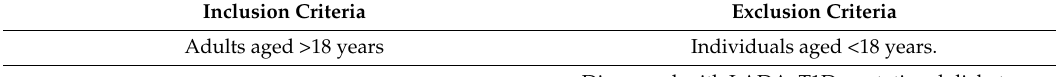
Table 1. Inclusion and exclusion criteria for the 3D Longitudinal Study. Inclusion